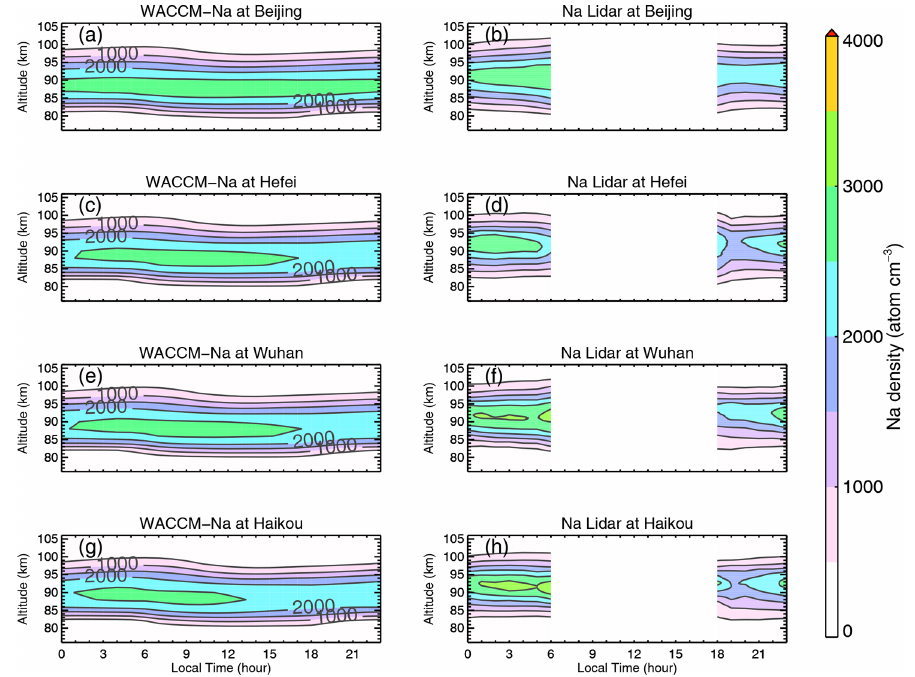
Figure 14. Diurnal variations of the WACCM simulated Na number density and the lidar-observed nighttime Na number density (a–b) at Beijing, (c–d) at Hefei, (e–f) at Wuhan, and (g–h) at